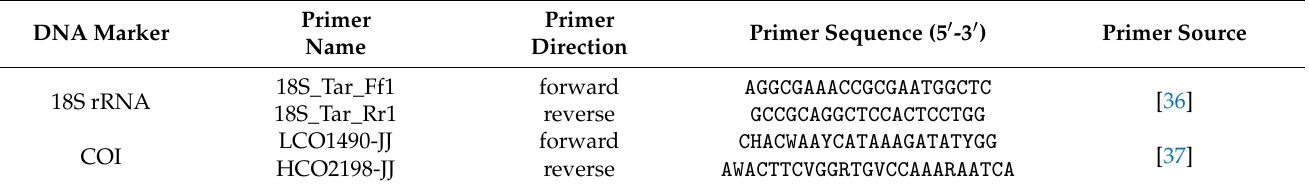
Table 1. Primers with their original references used for amplification of the four DNA fragments sequenced in the